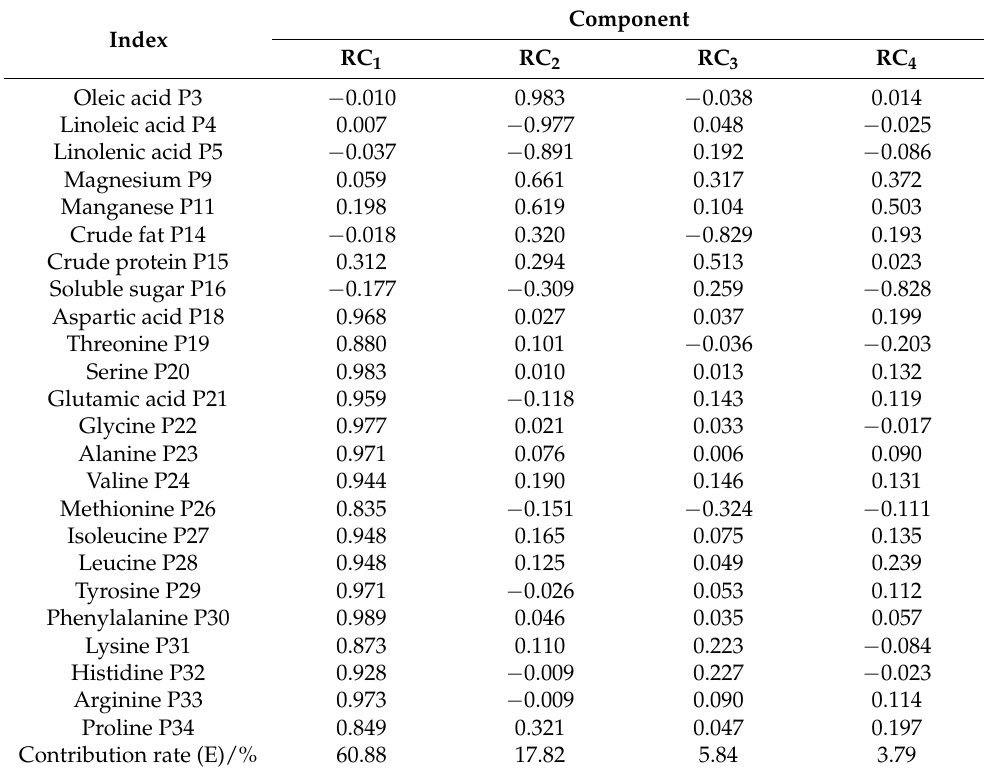
Table 5. The matrix of each principal components in the nutrient